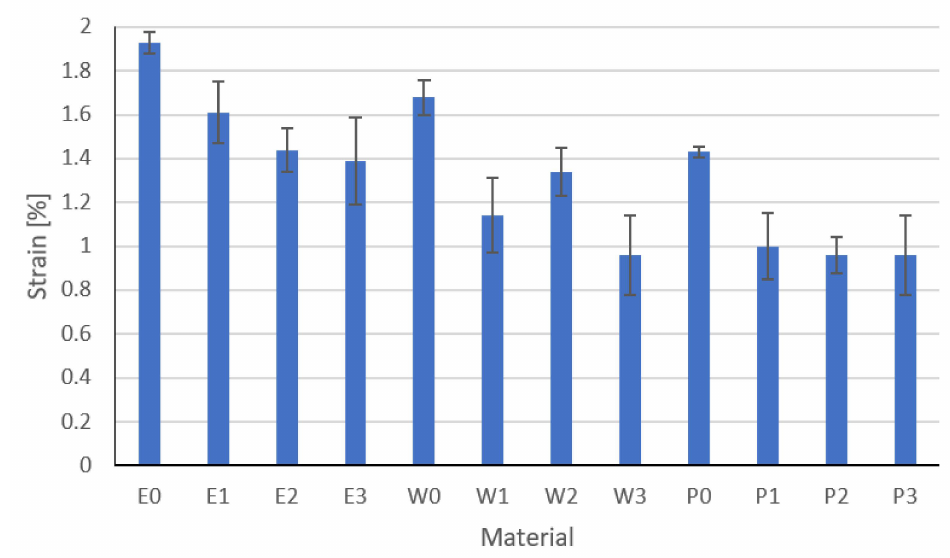
Figure 16. Strain at break